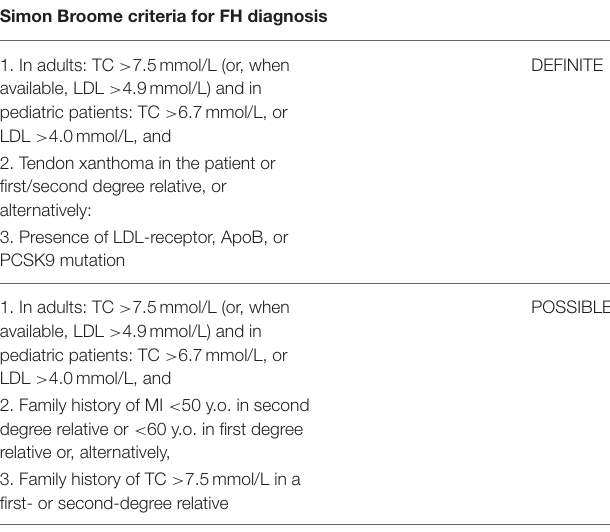
TABLE 3 | Simon Broome criteria for diagnosis of familial hypercholesterolemia. Simon Broome criteria for FH